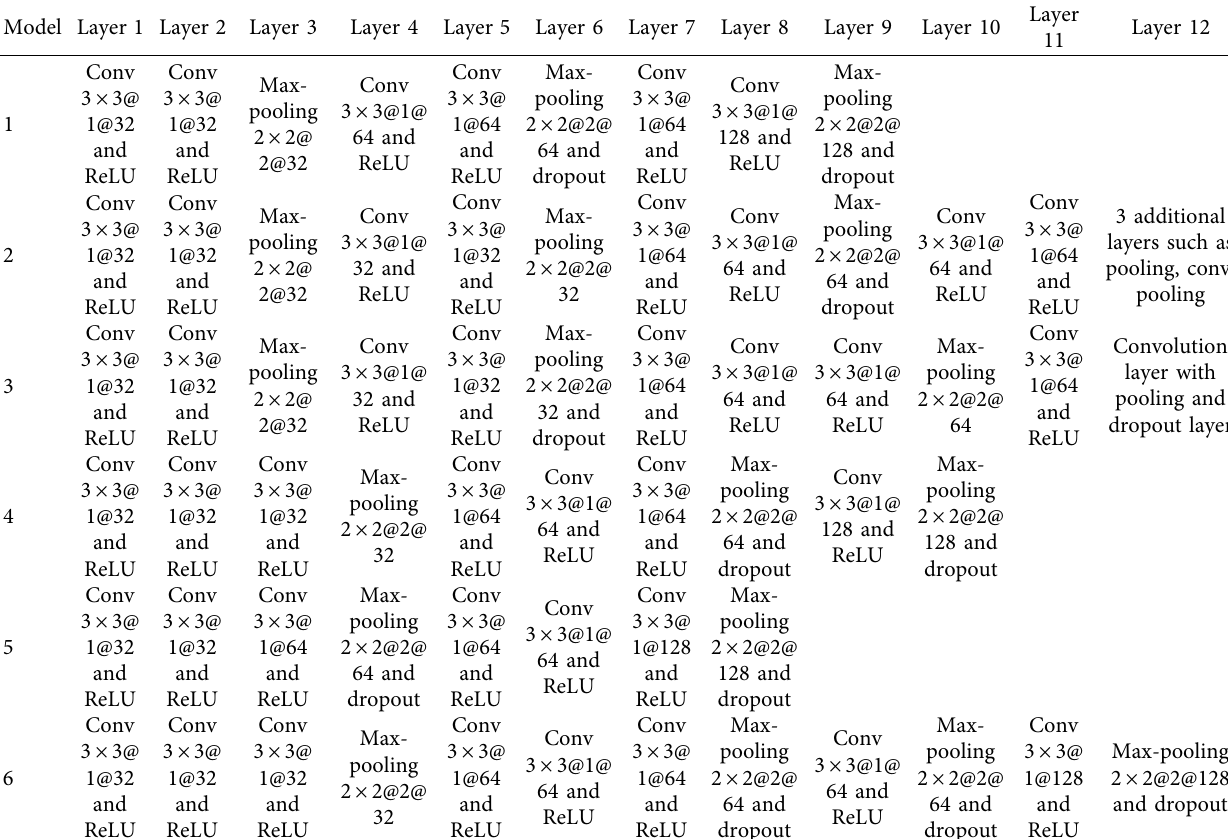
Table 3: Te CNN models for Geez handwritten digit recognition.